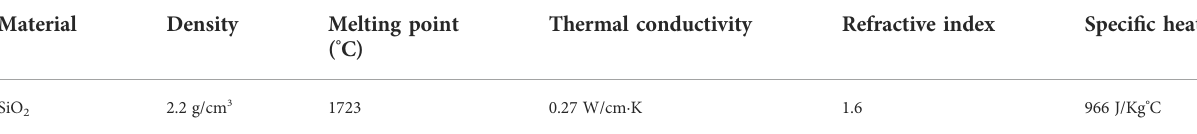
TABLE 2 Physical parameters related to glass beads.